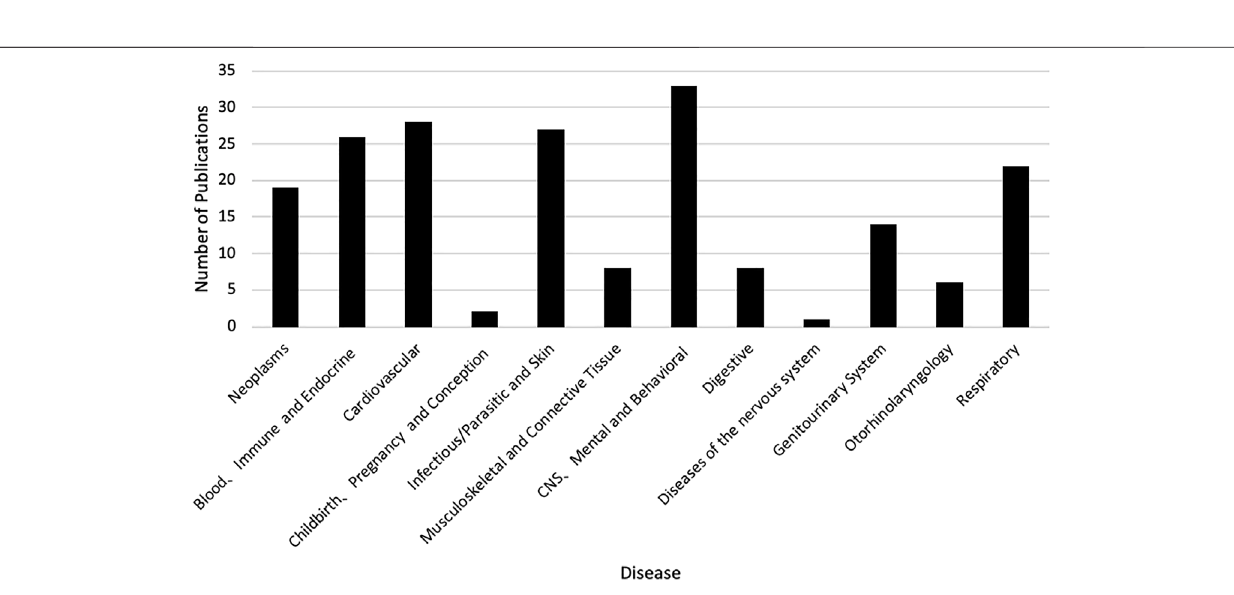
Frontiers in Pharmacology |